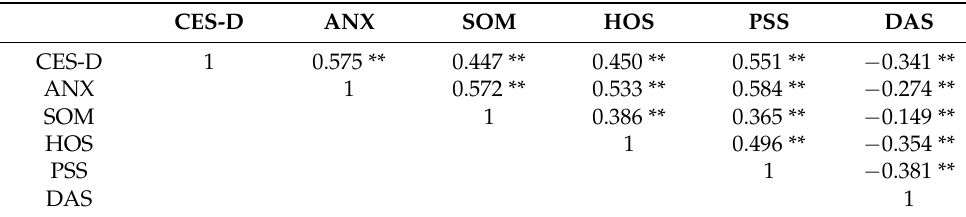
Table 3. Bivariate correlations among the variables.